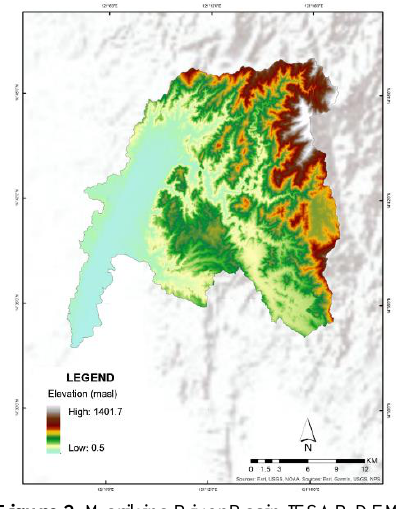
Figure 2. Marikina River Basin IFSAR DEM.